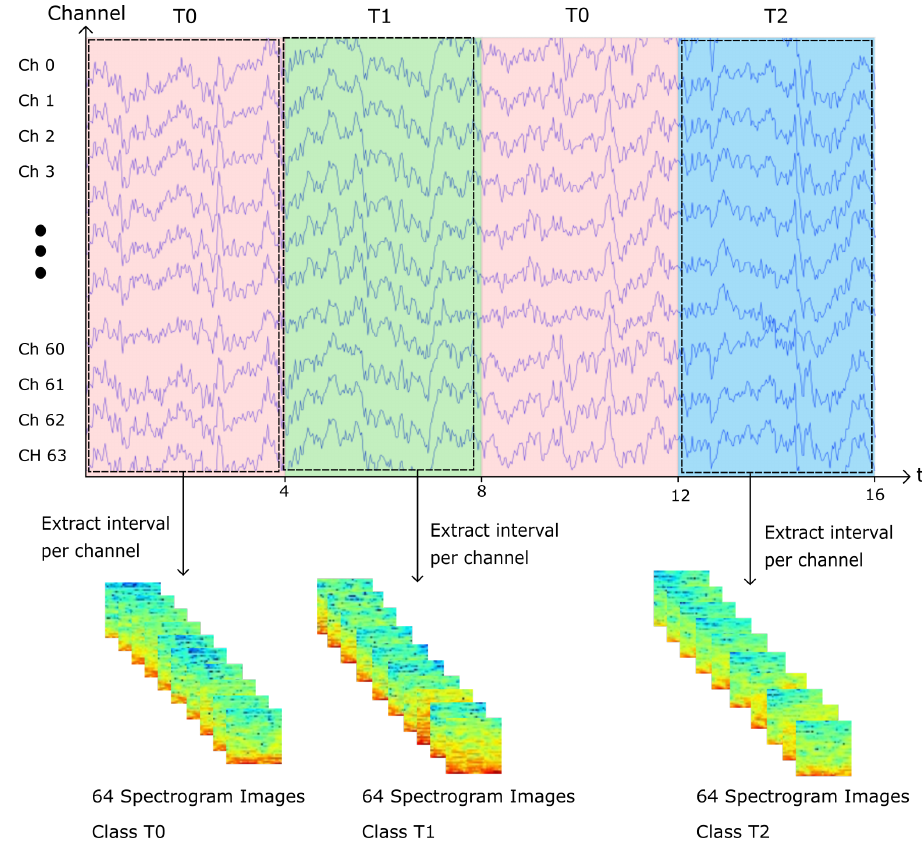
Figure 4. Single-channel spectrogram image generation example. For each class, the interval of time is extracted and transformed into a spectrogram image per